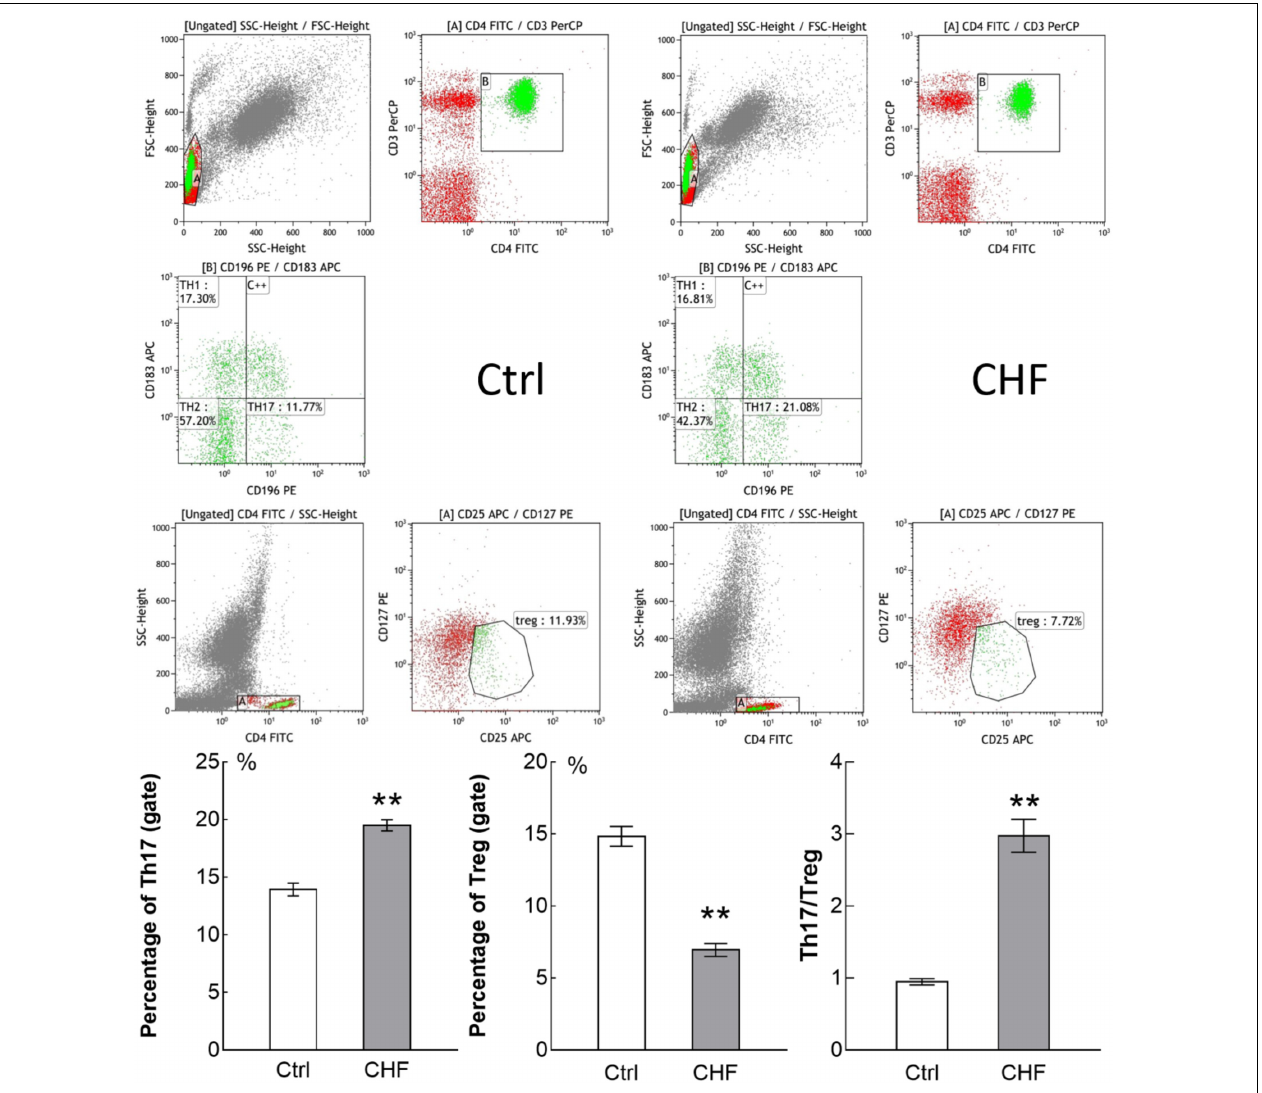
FIGURE 1 | Flow cytometry assay showed the percentage of Th17 cells and Treg cells in CHF patients (25 cases) compared to control subjects (15 cases). The original flow cytometry plots of the two groups is displayed above, and histogram comparison of Th17, Treg cells and the ratio of Th17/Treg is displayed below.